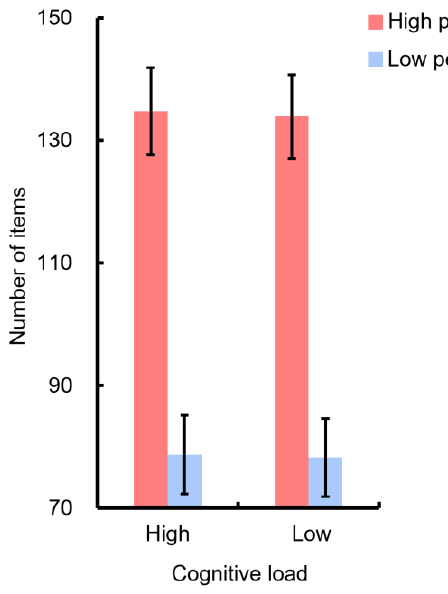
Figure 4. The average number of items (including the objects and word tiles) presented in the four mental workload conditions. Error bars indicate one standard error from the mean.